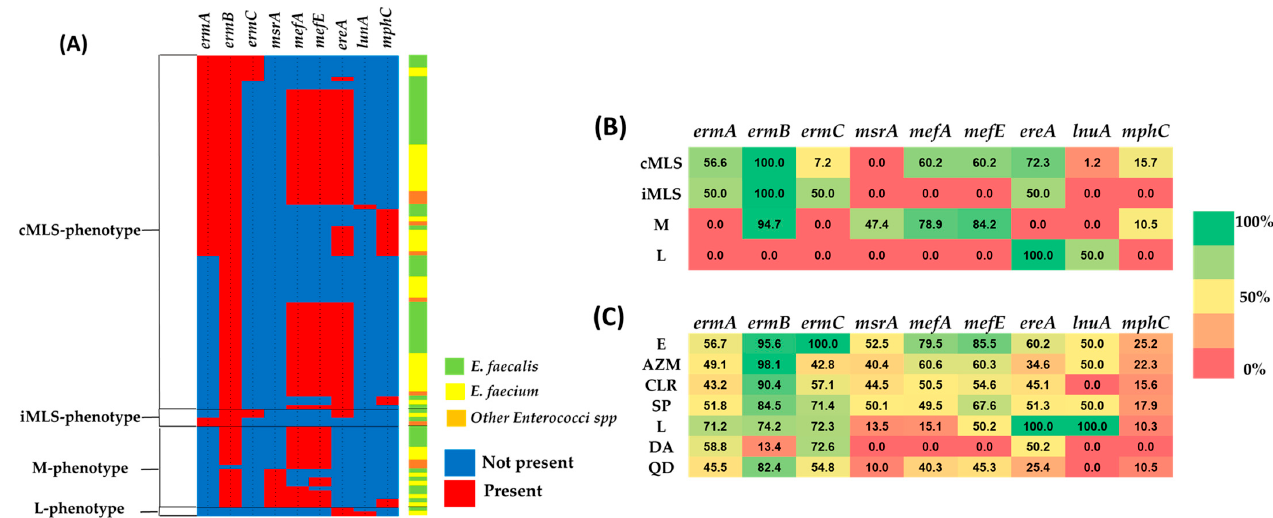
Figure 5. MLS resistance genotypes. ( A ) The distribution of the genes involved in the resistance to MLS in the different resistant isolates. The erm genes, particularly ermB, were the most predominant in all resistant isolates. ( B ) Heat map represents the percentage of the MLS resistance genes in different phenotypes. ( C ) Heat map represents the distribution of resistance genes in the resistance to different antibiotics.